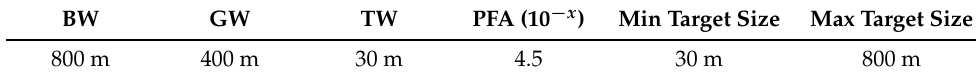
Figure 9. Test case of the CFAR+SLA algorithm over the port of Taranto. Highlighted detail: a probable radio signal transmitted from a ship and captured by X-band spaceborne SAR. Product ID: CSKS 1_ SCS _ BHI _05_ HH _ RD _ SF _20200323164522_2020032316_4529, processed by University of Naples Federico II under the COAST license of the Italian Space Agency (ASI). Original COSMO- SkyMed Product ©ASI (2020). Table 5. Configuration of the paramaters of the CFAR algorithm.